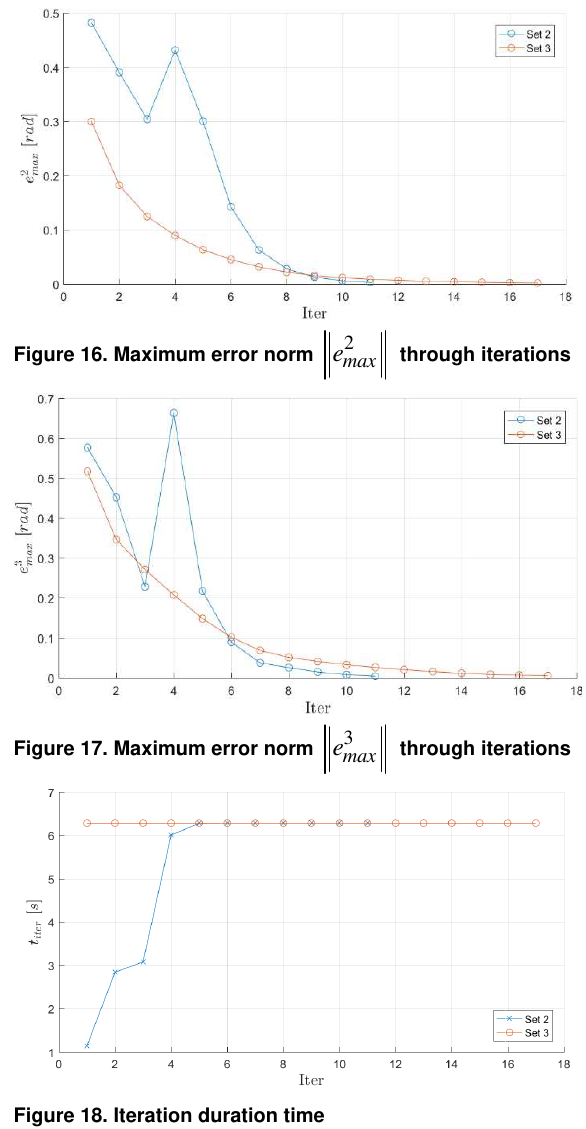
Figure 13. Maximum error norm